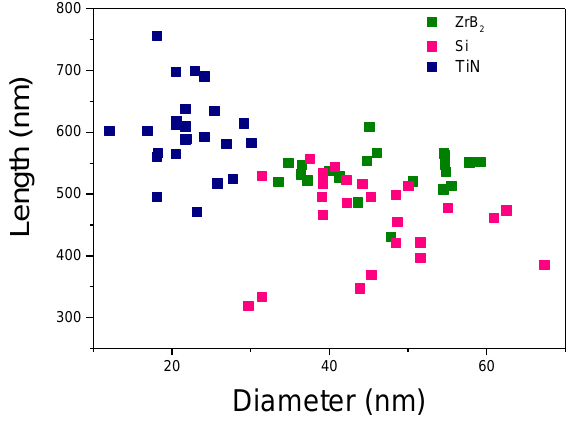
Figure 4. Length versus diameter distribution of GaN NRs grown at optimized temperatures on different templates (1 h growth).